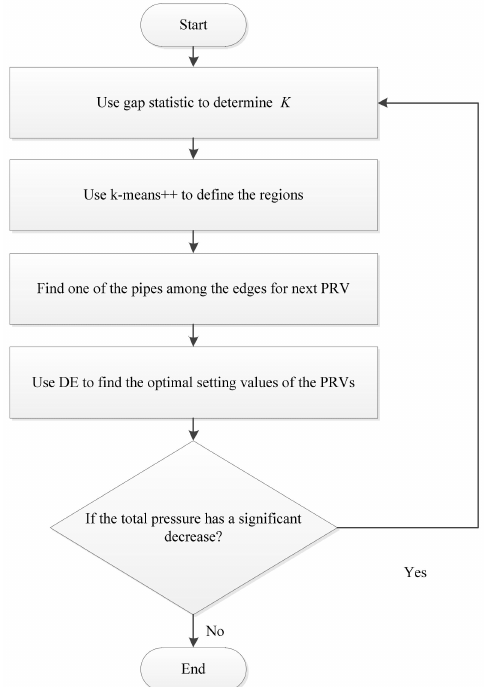
Figure 3. Algorithm of the proposed